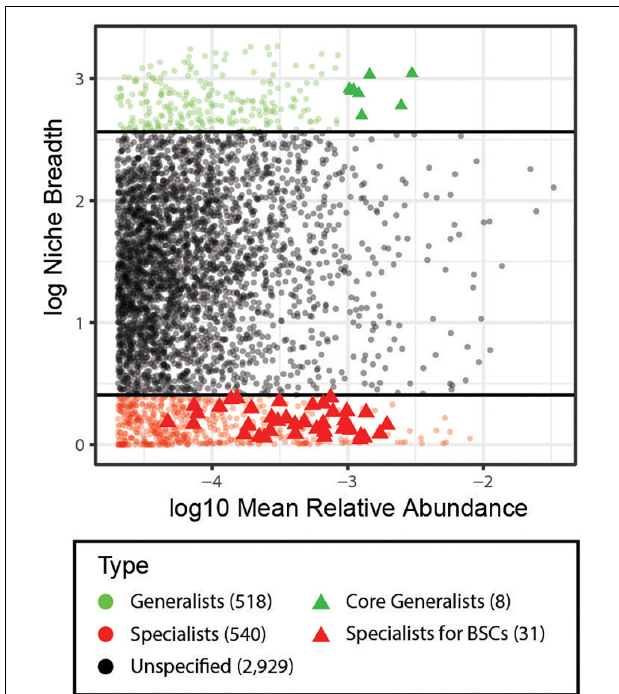
FIGURE 3 | Analysis of habitat specialists and generalists. Niche breadth of OTUs identified across all sample types (BS, BSC_sub, and BSCs). Each symbol represents an OTU. OTUs that are present along a wider range of habitats have a higher niche breadth value and are considered habitat generalists (green), while OTUs with a niche breadth value < 1.5 are considered habitat specialists (red), and the black circles represent OTUs that could not be defined as generalists or specialists. Generalists with highest abundance (ubiquity cutoff: 94%, abundance cutoff: 4%) are considered as core generalists (green triangle). Specialists with significant INDVAL values (cutoff: > 0.3) are specialists for BSCs (red triangle). Numbers outside of the square was represent the number of OTUs for each category. BS, bare soil; BSC_sub, biocrust subsurface soil; BSCs,